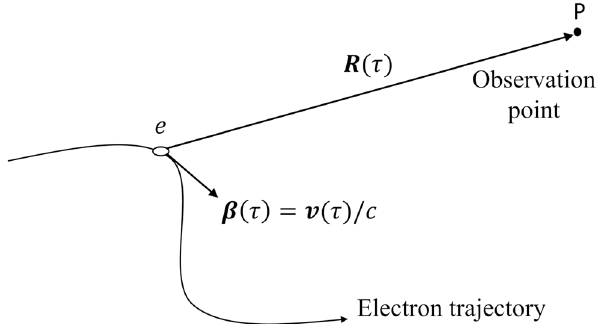
FIG. 1. A diagram showing the electron ’ s trajectory and introducing variables for the SR calculation in Eq. (1).